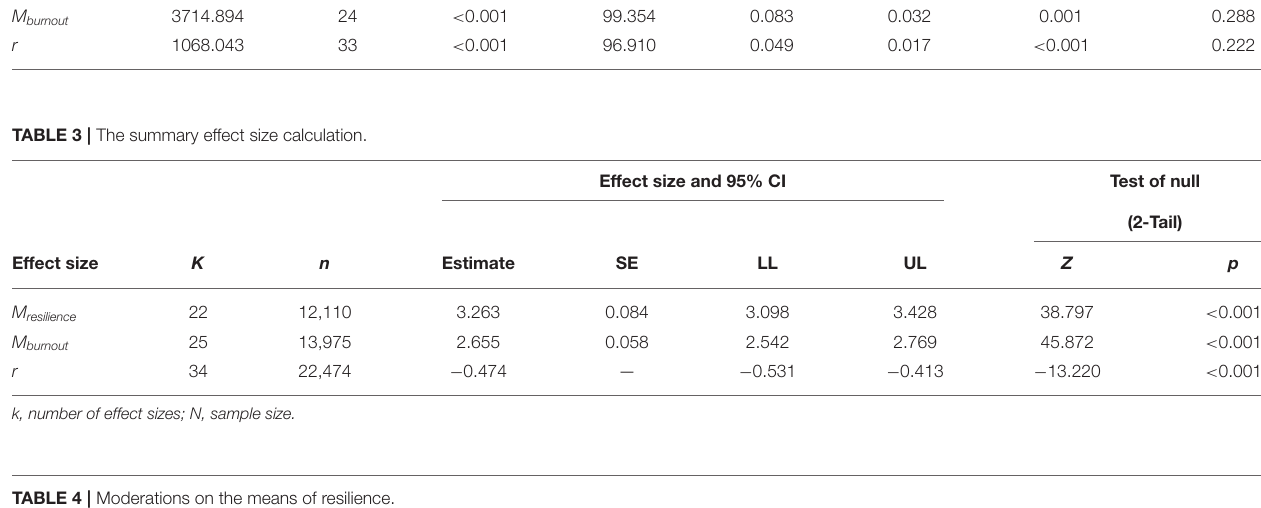
TABLE 4 | Moderations on the means of